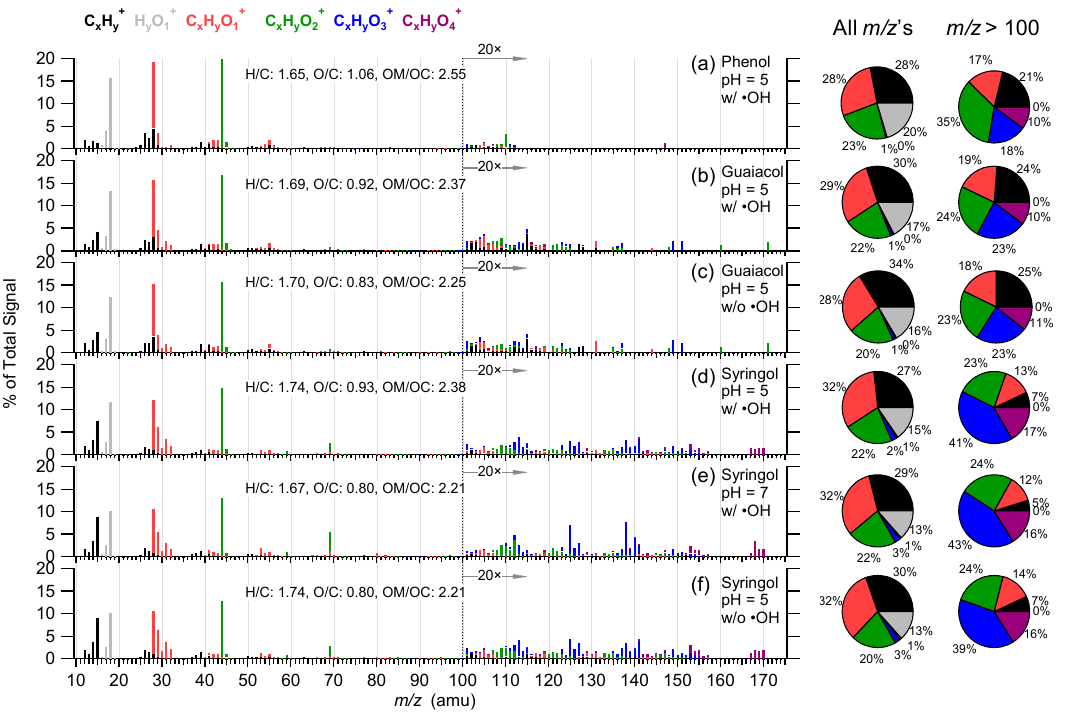
Fig. 1. HRMS of the SOA products of (a) phenol, (b–c) guaiacol, and (d–f) syringol formed via aqueous-phase photochemical reactions. Each peak in the HRMS is colored based on the contributions from 6 ion categories: C x H + y , H y O + C x H y O + . The ion signals at m/z > 100 are enhanced by a factor of 20 for clarity. The pie charts show the relative contributions of each ion 4 category to individual SOA material. The experimental conditions and the calculated atomic ratios are shown in the